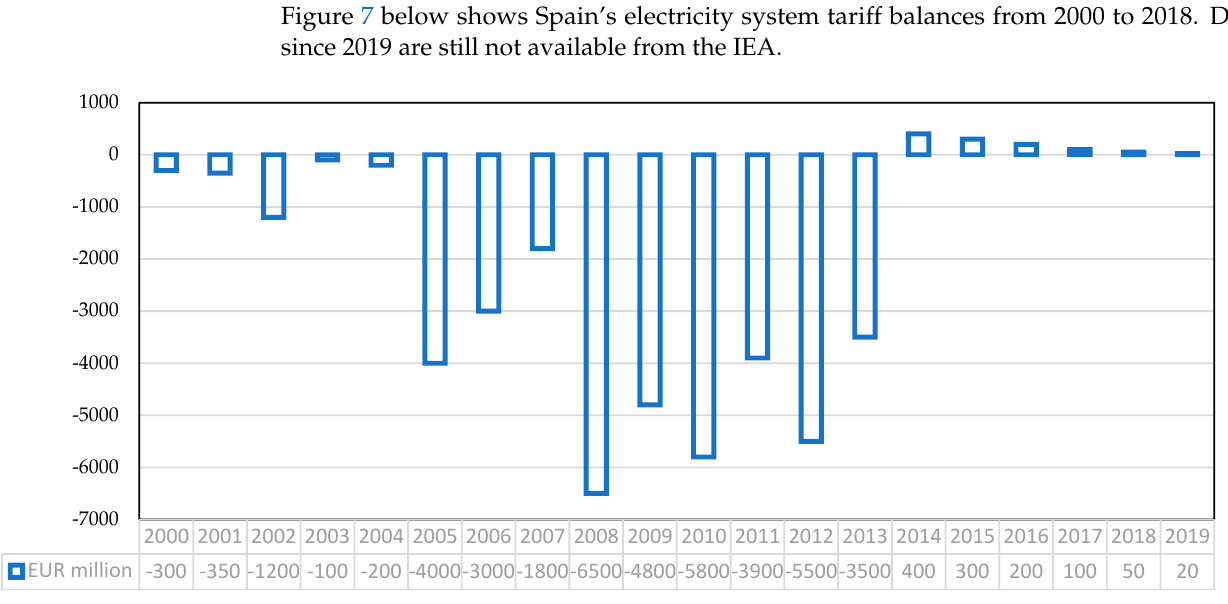
Figure 7. Spain’s electricity system tariff balances from 2000 to 2018. Source: Own elaboration from Spanish government response to the IEA questionnaire in [2].